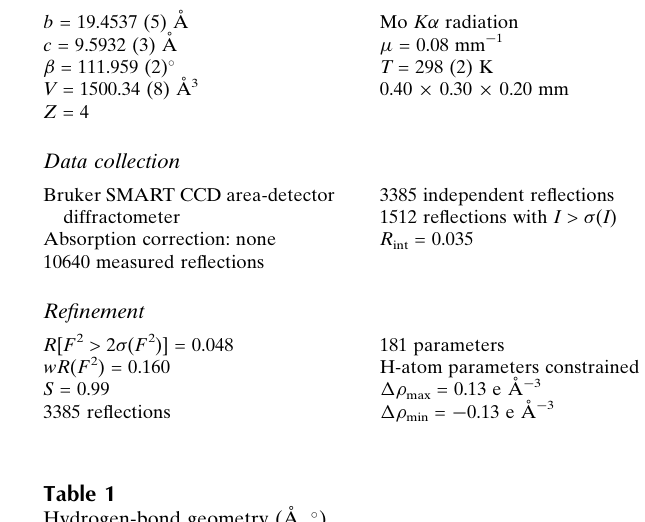
Hydrogen-bond geometry (A˚ , (cid:3)